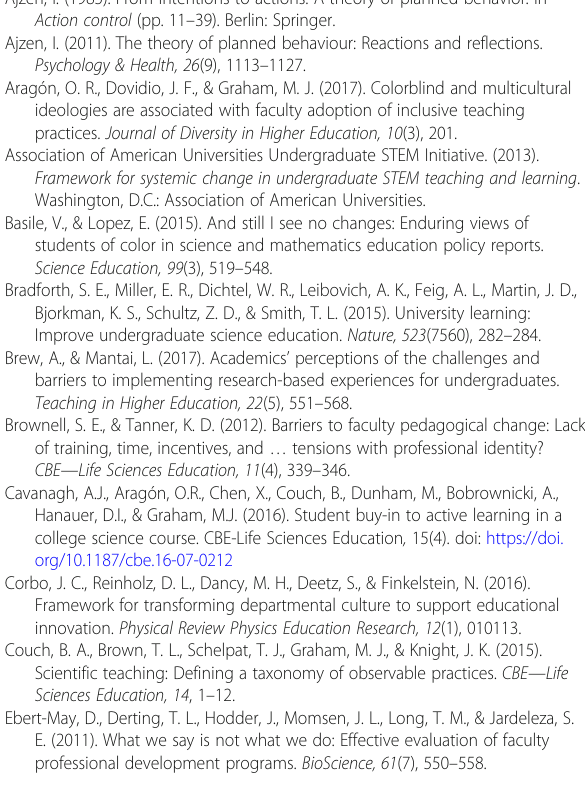
Table S1. Mapping of implementation items to the taxonomy in Couch et al. (2015). (DOCX 408